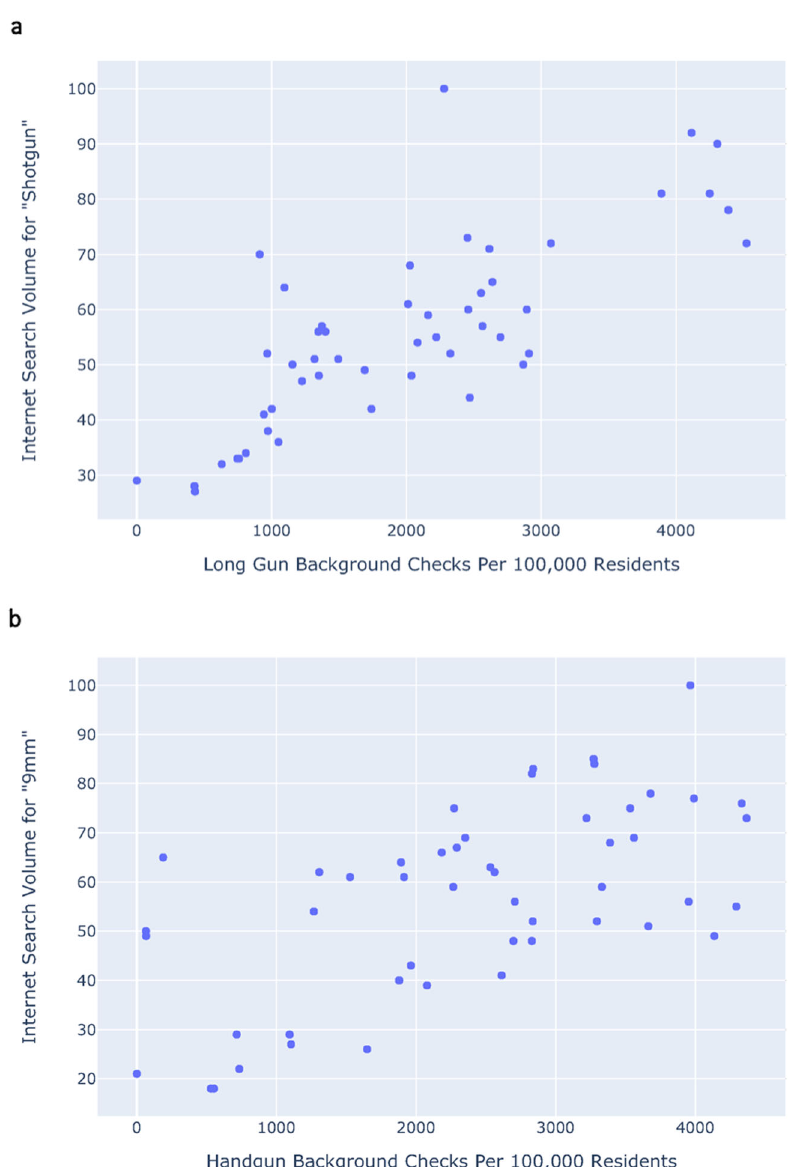
Fig. 3 State-by-state comparisons of background checks vs. search volumes. a U.S. long-gun background checks vs. U.S. relative Internet search volume for the term shotgun (Pearson ’ s r = 0.78, Spearman ’ s ρ = 0.76). b U.S. handgun background checks vs. U.S. relative search Internet search volume for the term 9 mm (Pearson ’ s r = 0.63, Spearman ’ s ρ = 0.59) across all 50 US states in